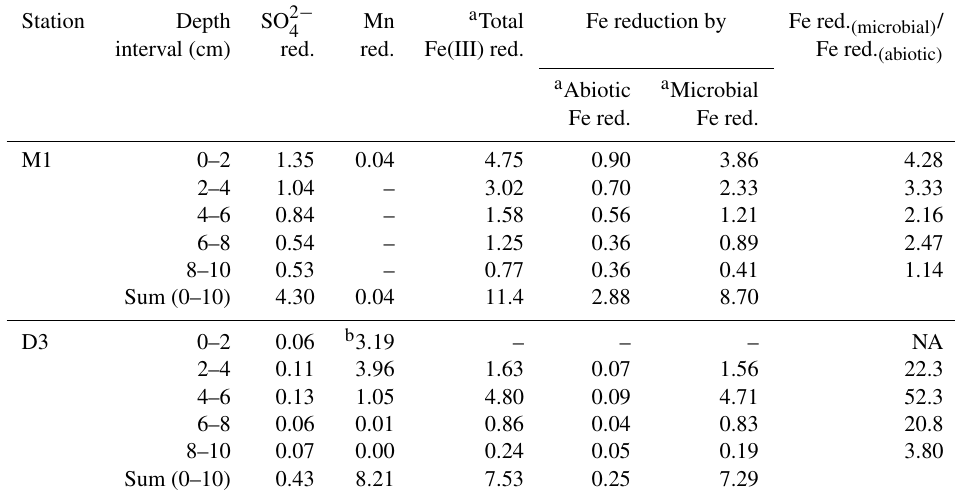
Table 3. Depth-integrated rates (mmolm − 2 d − 1 ) of Mn reduction, Fe reduction, and sulfate reduction and the partitioning of abiotic and microbial Fe(III) reduction in total Fe(III) reduction with depth.